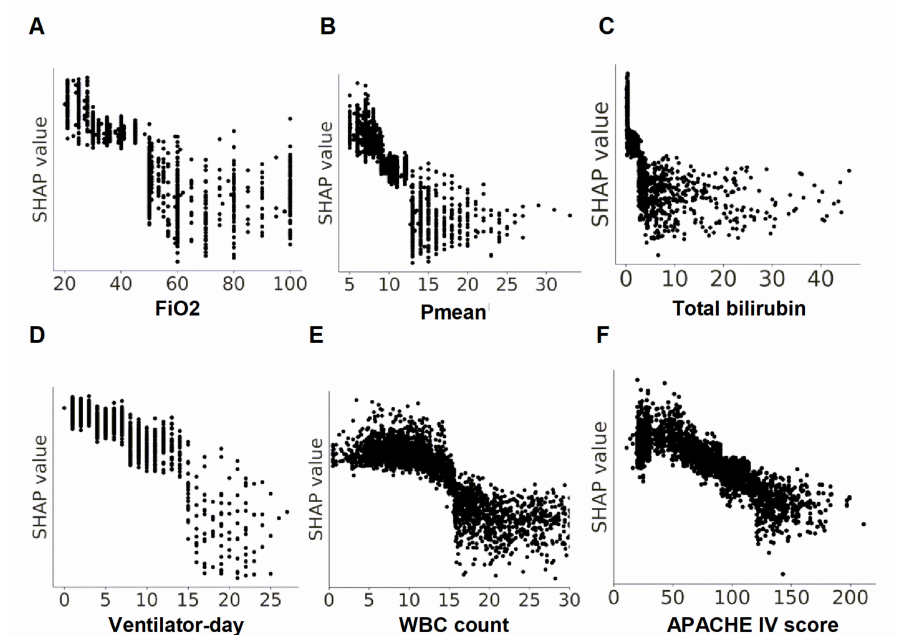
Figure 5. Partial dependence plots of key features ( A ). FiO 2 , ( B ). Pmean, ( C ). Total bilirubin, ( D ). Ventilator day, ( E ). WBC count. ( F ). APACHE IV score. The partial dependence plot showed the marginal effect of each feature on the weaning outcome. Abbreviation: FiO 2 , the fraction of inspired oxygen; Pmean, mean airway pressure; WBC, white blood cell; APACHE IV, acute physiology, and chronic health evaluation